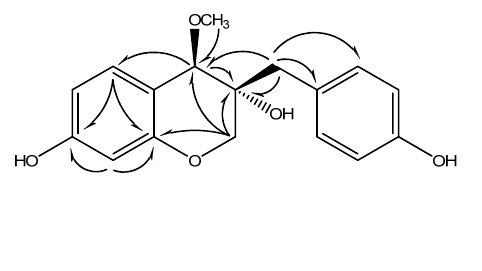
Figure 2. Main HMBC correlations of ( 4